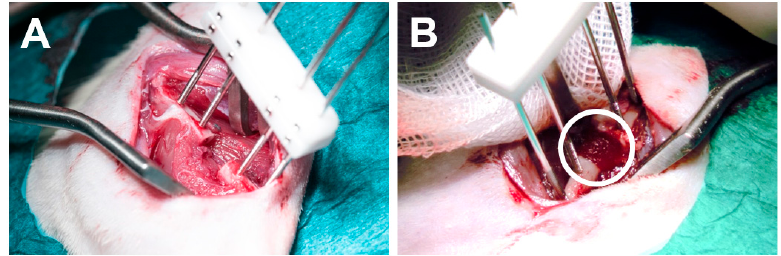
Figure 4. ( A ) Intraoperative view of the critical sized defect in the right femur before and after ( B ) placement of the silk scaffold.